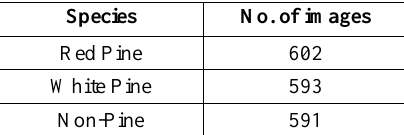
Table 2. The composition of training